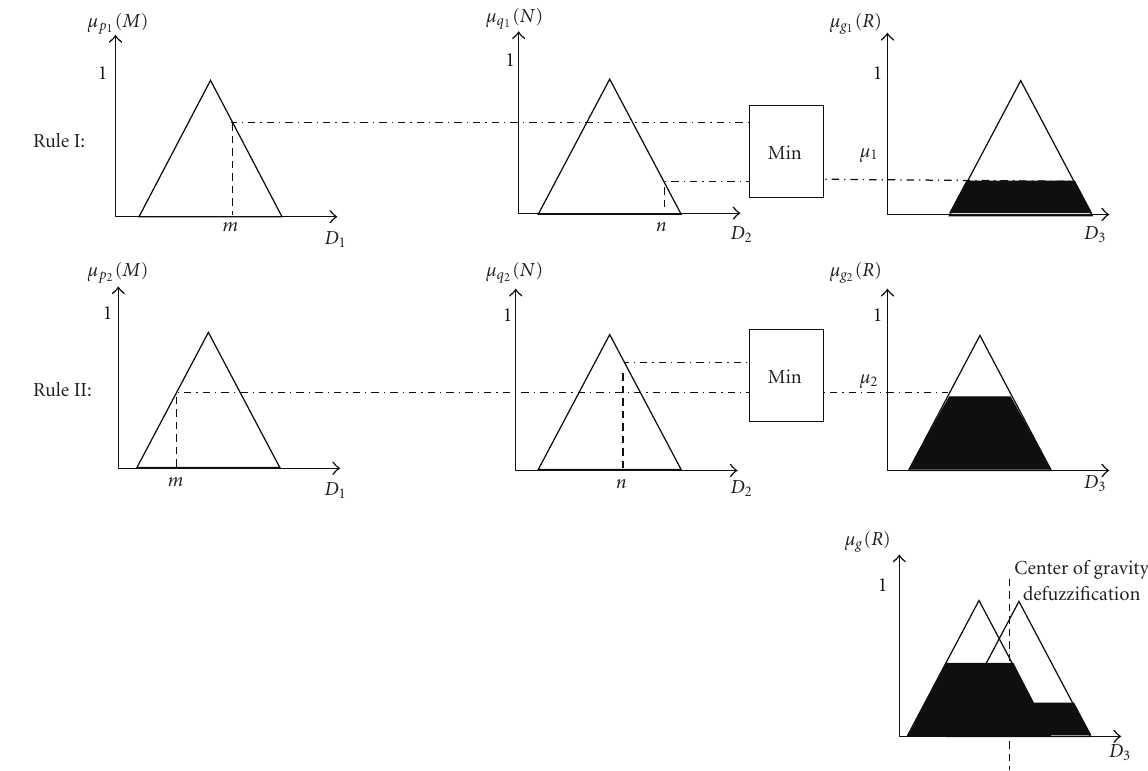
Figure 1: Fuzzy inference procedure for two rules based on Mamdani’s type.